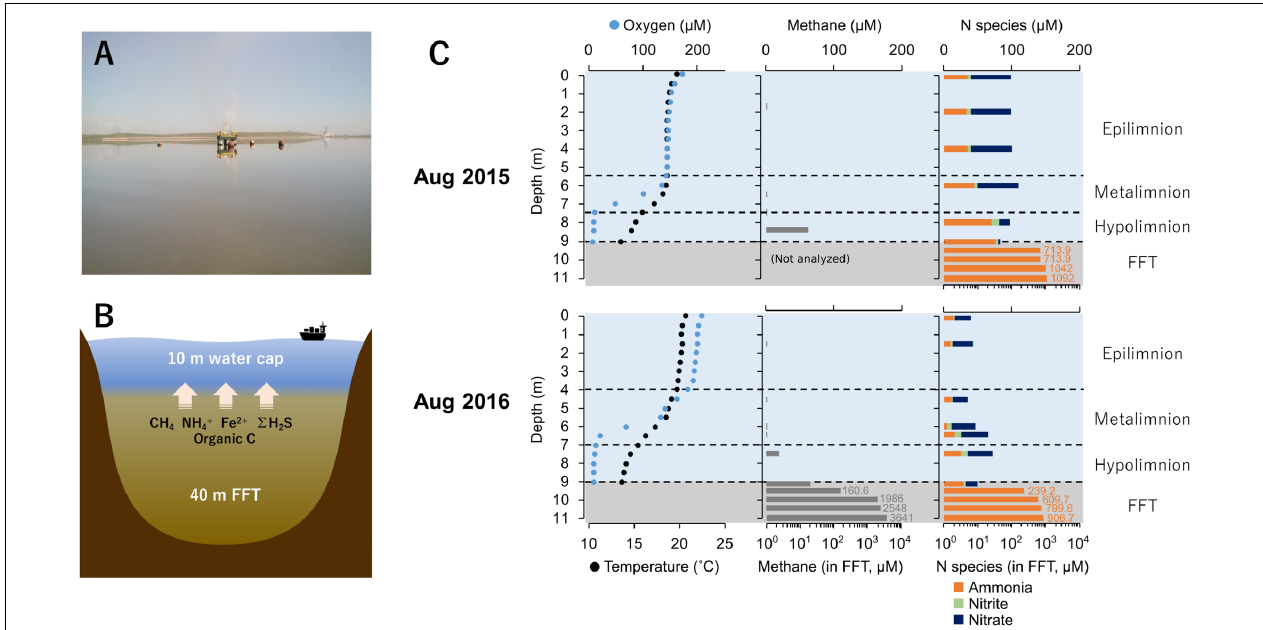
FIGURE 1 | (A) Base mine lake identifying the sampling platform where samples were collected (August 2016). (B) Cross-section model of Base Mine Lake showing main reductants released from the ∼ 40 m layer of fluid fine tailings (FFT). (C) Base Mine Lake physicochemical and geochemical water cap and shallow (2 meter) of underlying FFT profiles for August 2015 and 2016. Dissolved oxygen concentration ( µ M) and temperature ( ◦ C) in the left column, dissolved aqueous methane concentration ( µ M) in the center column, and concentrations of three N redox species (ammonia, nitrite and nitrate; µ M) in the right column. Nitrogen species concentrations for 2015 were obtained from Syncrude’s Base Mine Lake monitoring program (depths 0, 2, 4, 6, 8, 9 m) collected on August 10th, 2015. Dissolved aqueous methane and ammonia concentrations in the FFT were measured on August 5th 2015 and August 13th